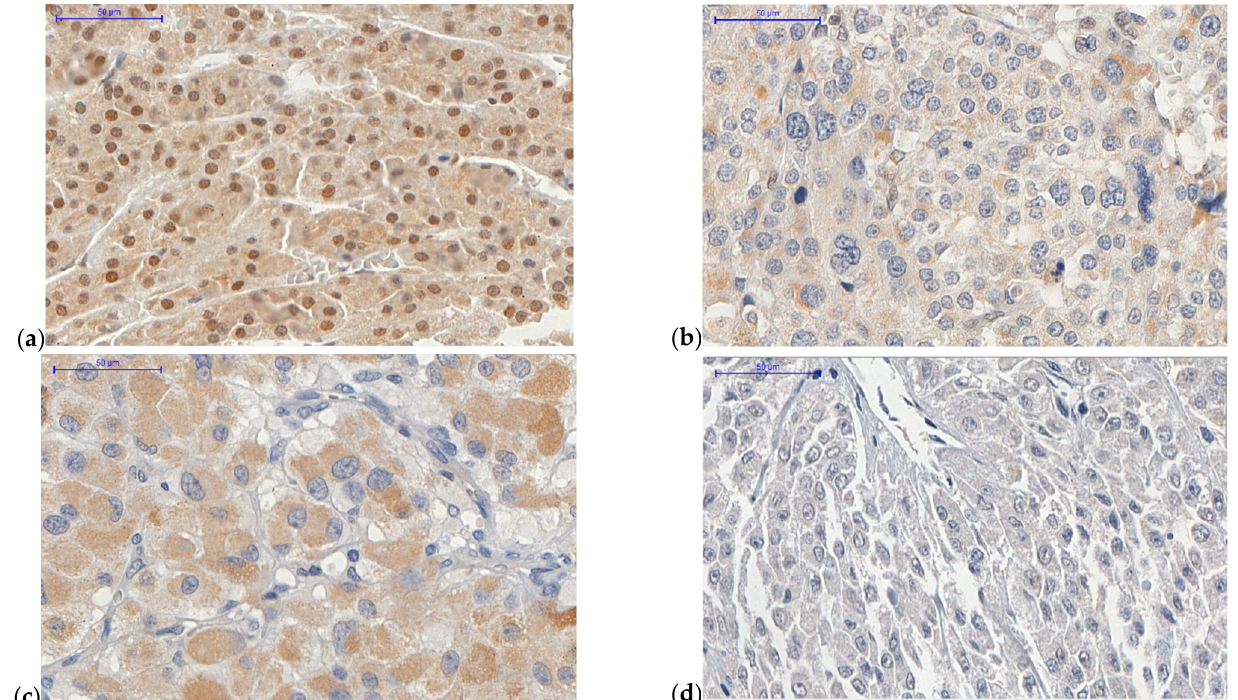
Figure 1. Adrenocortical carcinoma (ACC) samples of tissue microarray (TMA). Obj 40×. ( a ) ACC case 13 presenting high ATRX nuclear expression (score 4). Female patient, aged 28.7 y with virilizing syndrome, a Weiss score 3, and a European Network for the Study of Adrenal Tumors (ENSAT) system score of 2. ( b ) ACC case 32 with low ATRX nuclear expression (score 0). Female patient, aged 26.5 y with mixed syndrome (hypercortisolism and androgen excess), a Weiss score of 7, and an ENSAT system score of 4. ( c ) ACC case 77 with high ZNRF3 cytoplasmic expression (score 5; extent = 4, intensity = 1). Male patient, aged 65.6 y with mixed syndrome (hypercortisolism and androgen excess), a Weiss score of 6, and an ENSAT system score of 4. ( d ) ACC case 5 with low ZNRF3 cytoplasmic expression (score 0). Female patient, aged 85.4 y with hypercortisolism syndrome, a Weiss score of 7, and an ENSAT system score of 3. Scale bar = 50 μ m.